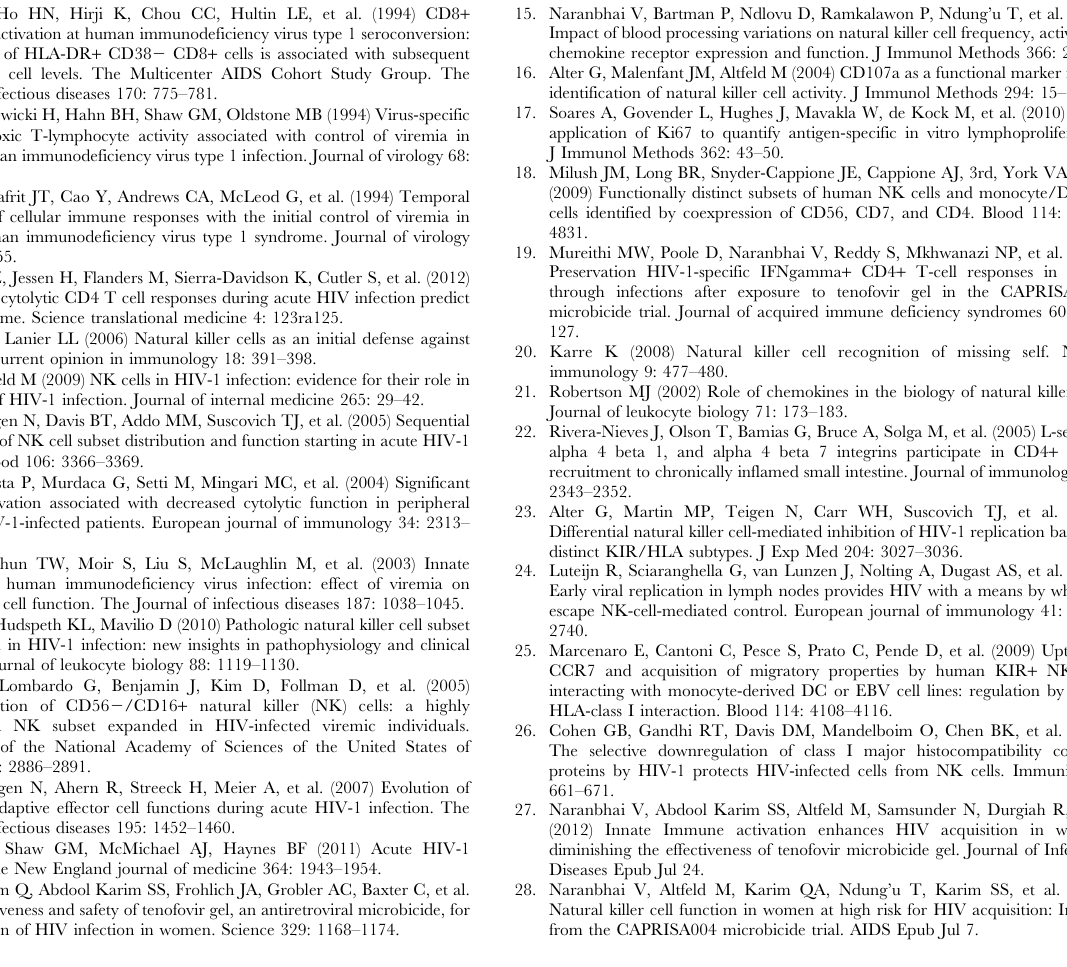
Figure S5 The proportion of recently divided CD8 + T-cells (A), and degranulating CD8 + T-cells (B) was increased in primary HIV infection but the proportion of CD8 pos T-cells secreting IFN- c was not significantly altered